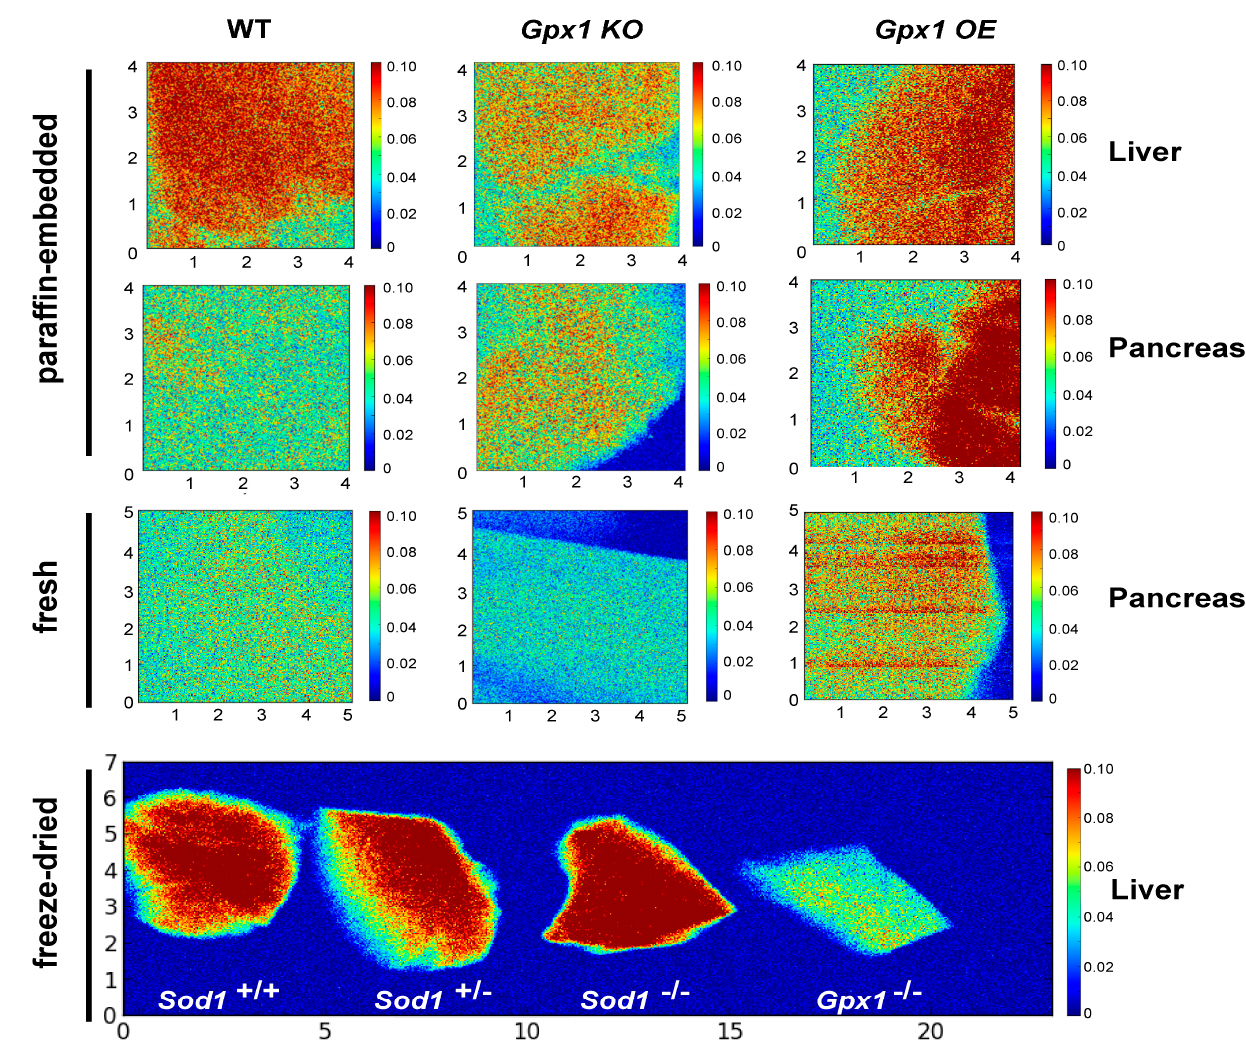
Figure 1. Synchrotron X-ray fluorescence (SXRF) Se imaging in pancreases and livers of wild-type, Sod1 − / − Gpx1 − / − and OE mice. The first two rows represent paraffin-embedded samples; the third row represents samples from freshly isolated pancreases. The fourth row represents Se distribution in liver of wild-type and Sod1 +/ − (1st and 2nd images from the left, respectively), Sod1 − / − and Gpx1 − / − samples (2nd and 1st image from the right, respectively). The Se map was acquired at 20 µ m resolution, with a 0.25 s/pixel dwell time using a focused, monochromatic incident X-ray beam of 12.2 keV. SXRF data were processed with Praxes, a CHESS-developed software for image analysis.